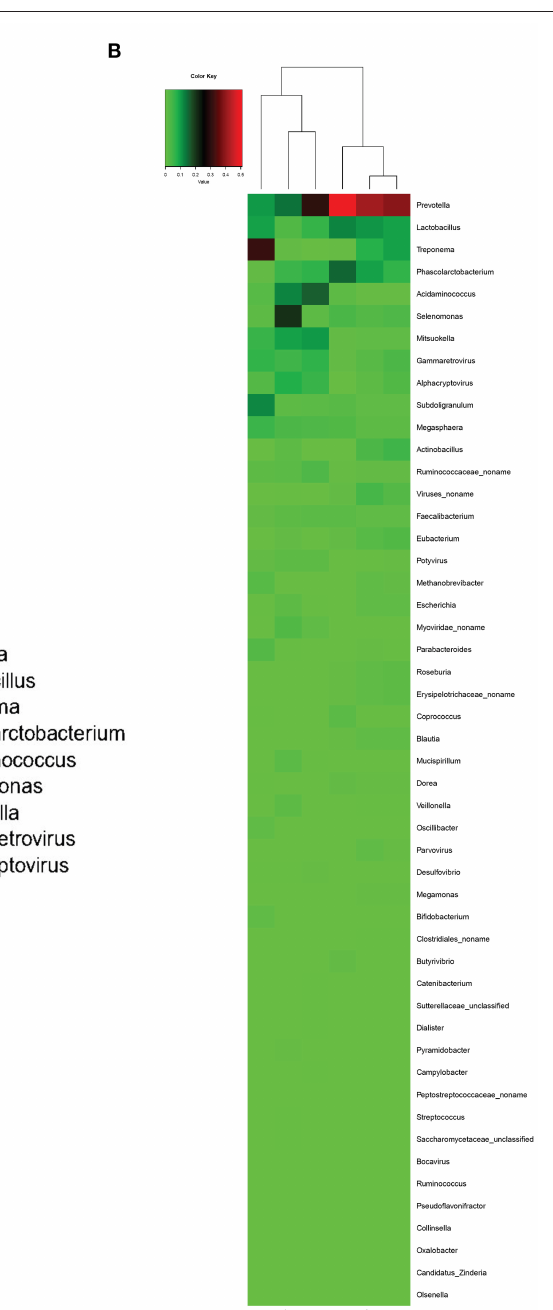
feed to promote animal growth, but it is now forbidden in China as an additive to enhance animal growth (Announcement